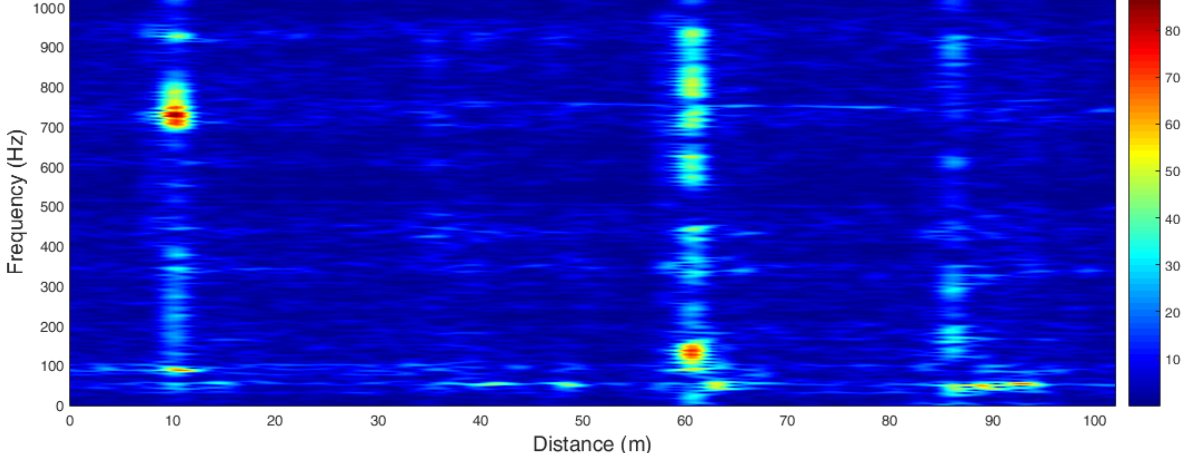
Figure 3. Scalogram of ABA signal.